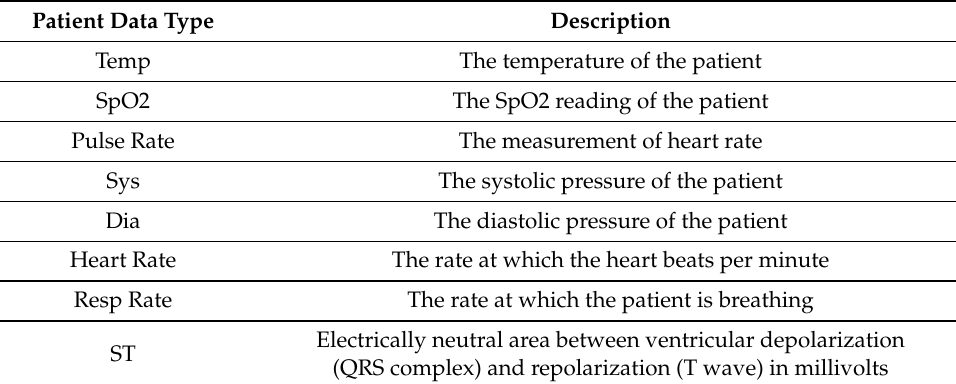
Table 2. Parameters considered for patient’s